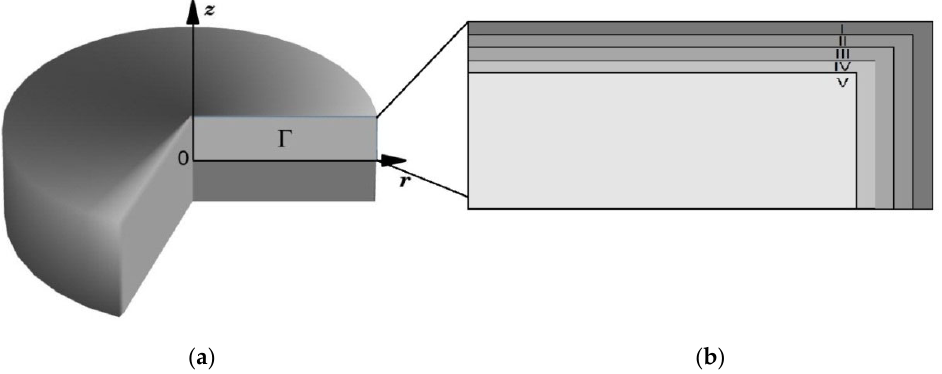
Figure 8. Schematic diagram of the ceramic composite: ( a ) Disk ‐ shaped composite sample; ( b ) Modeling area.